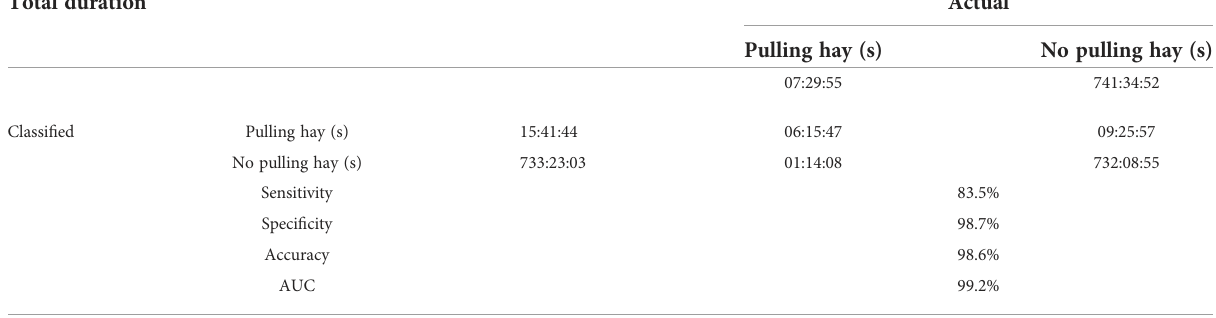
TABLE 4 Confusion matrix of RF classi fi cation of pulling hay behavior in the validation